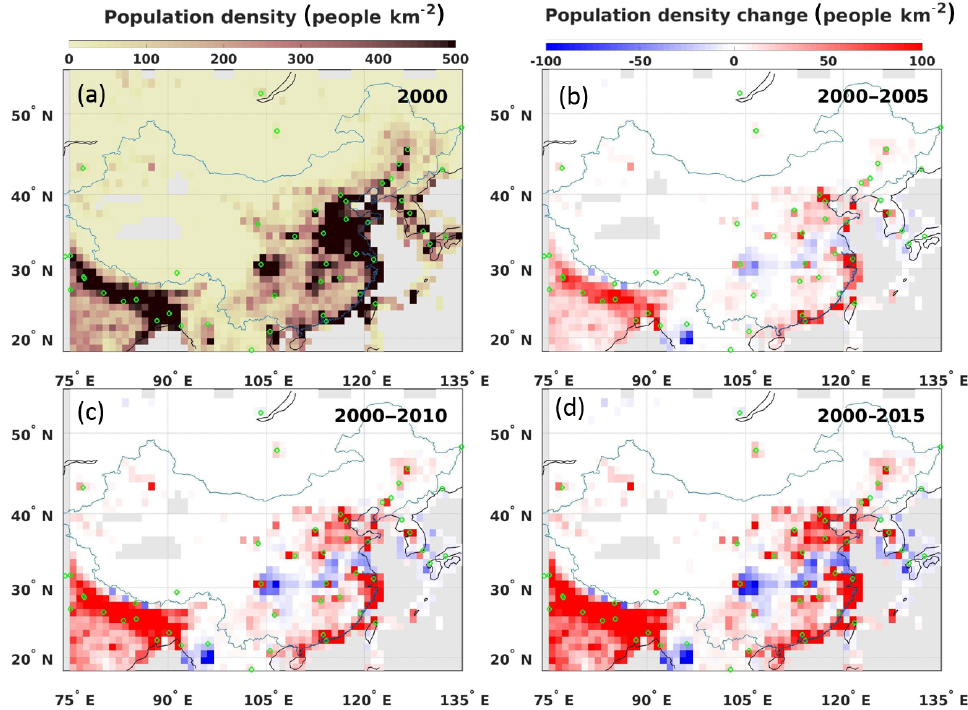
Figure 1. The population density in China (https://doi.org/10.7927/H4DZ068D, last access: 21 November 2018) in 2000, (a) and the popu- lation density change in 2005 (b) , 2010 (c) and 2015 (d) compared with 2000. Megacities are marked using green circles.